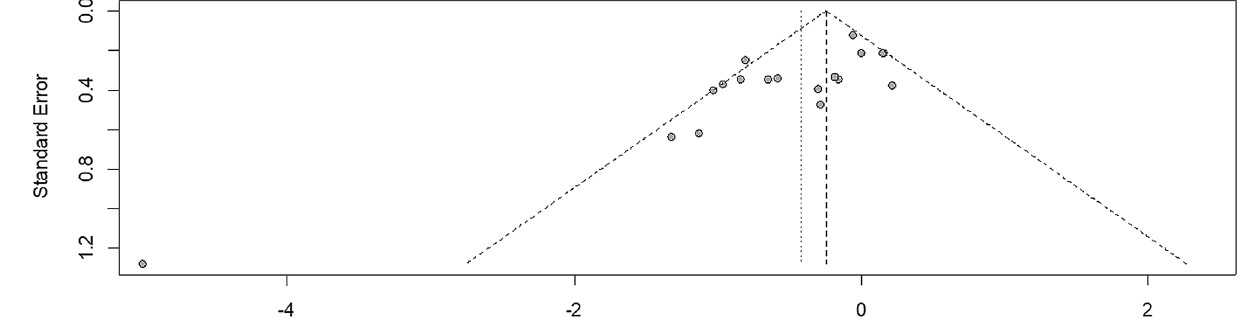
Figure 7. Funnel plot of the effect of high-intensity functional training vs. no-exercise (effect size against standard error). Note the the outlier on the lower